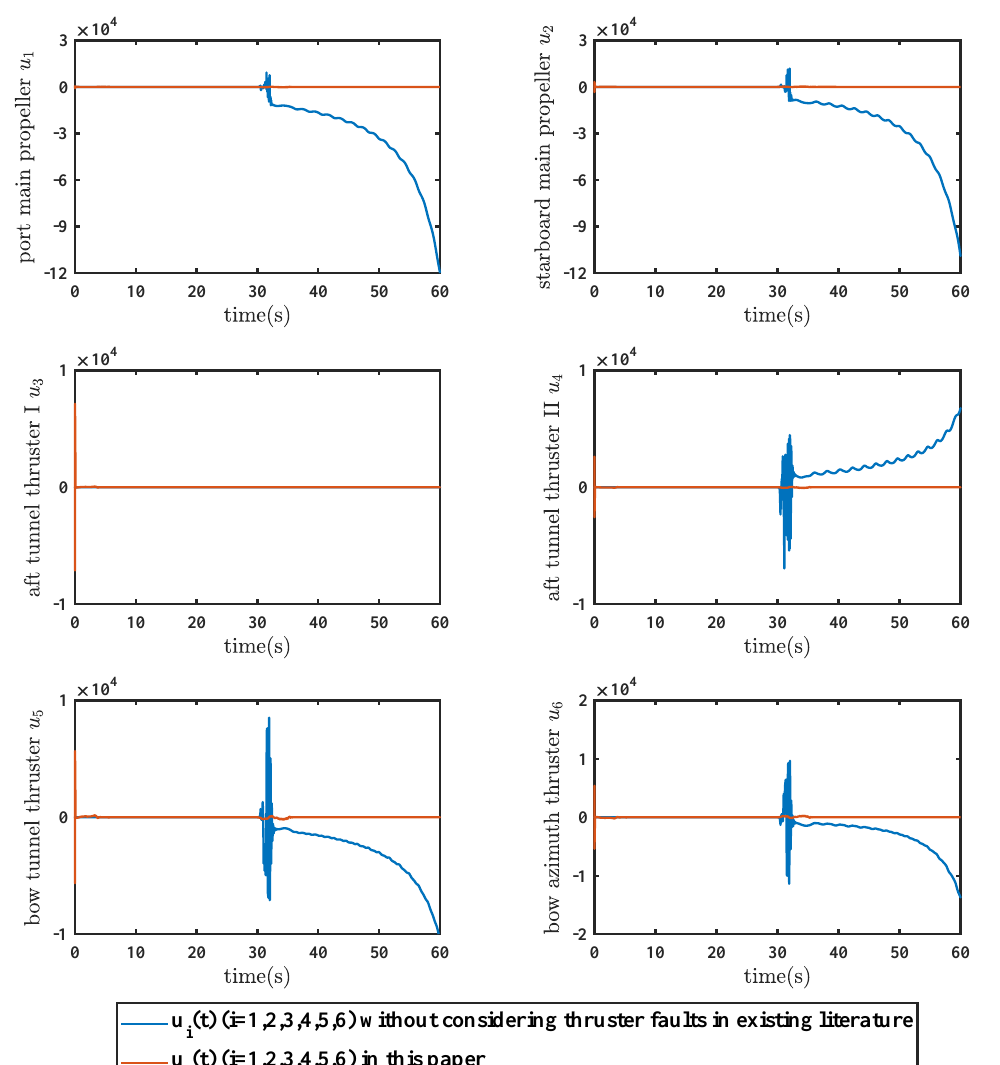
Figure 5. Comparison of controller responses u ( t ) with a normal controller and using the techniques developed in this